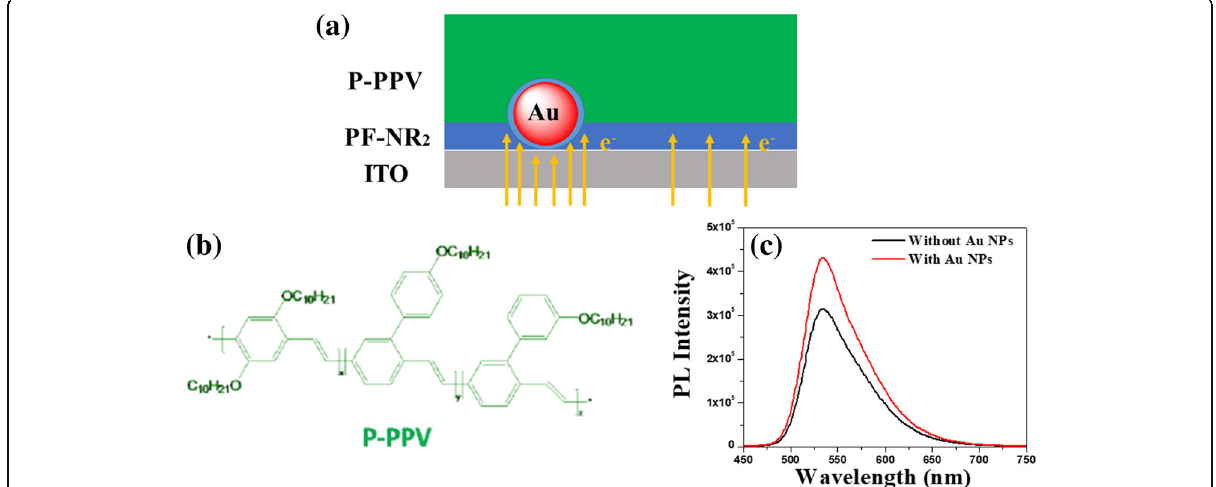
Fig. 6 a Schematics of the proposed enhanced electron transportation of the hybrid layer with an inverted structure. b Molecular structure of PF- NR 2 . c PL spectroscopy of P-PPV with and without Au